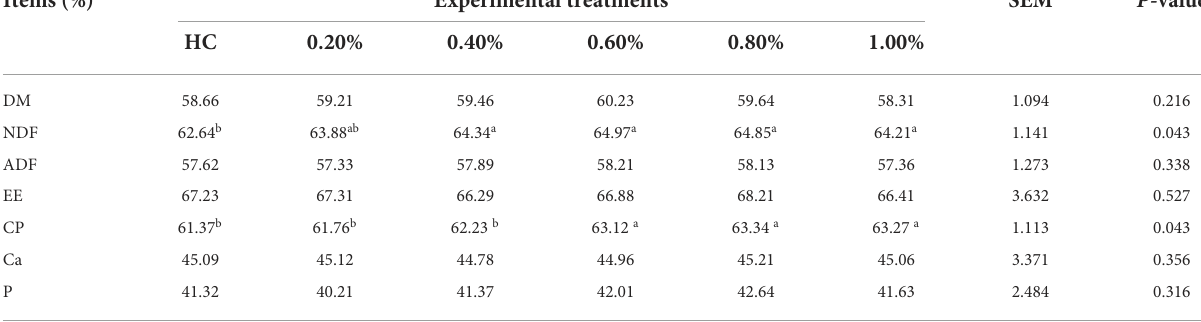
TABLE 3 Effects of small peptide supplement in high-concentrate diets on rumen nutritional degradability ( n , 6). Items (%)